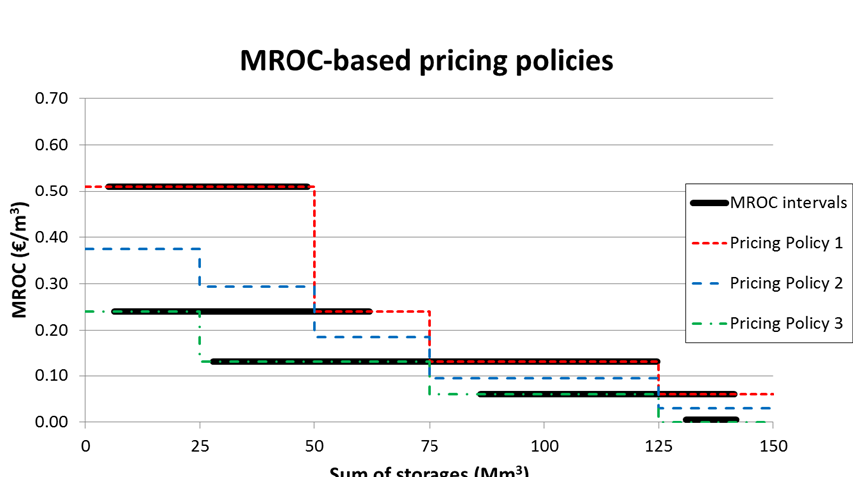
Figure 6. Combined MROC cumulative probability distribution.